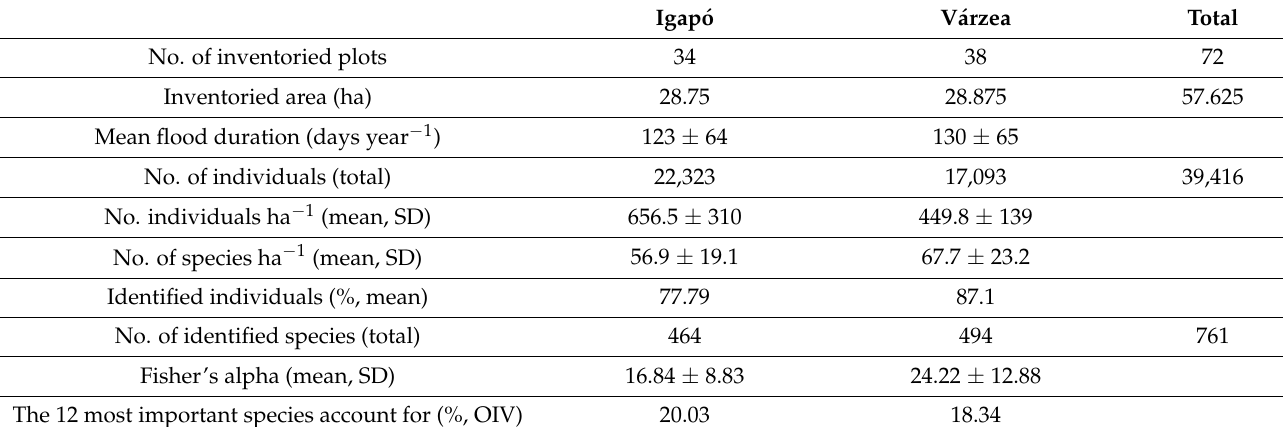
Table 2. Comparative floristic inventories of trees ≥ 10 cm of diameter at breast height (dbh) in central Amazonian igap ó and v á rzea forests, based on the floristic inventories presented in Table